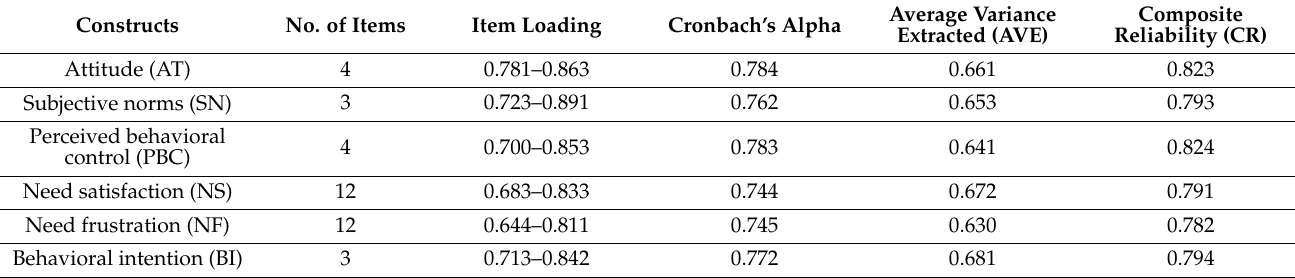
Table 2. Construct reliability and